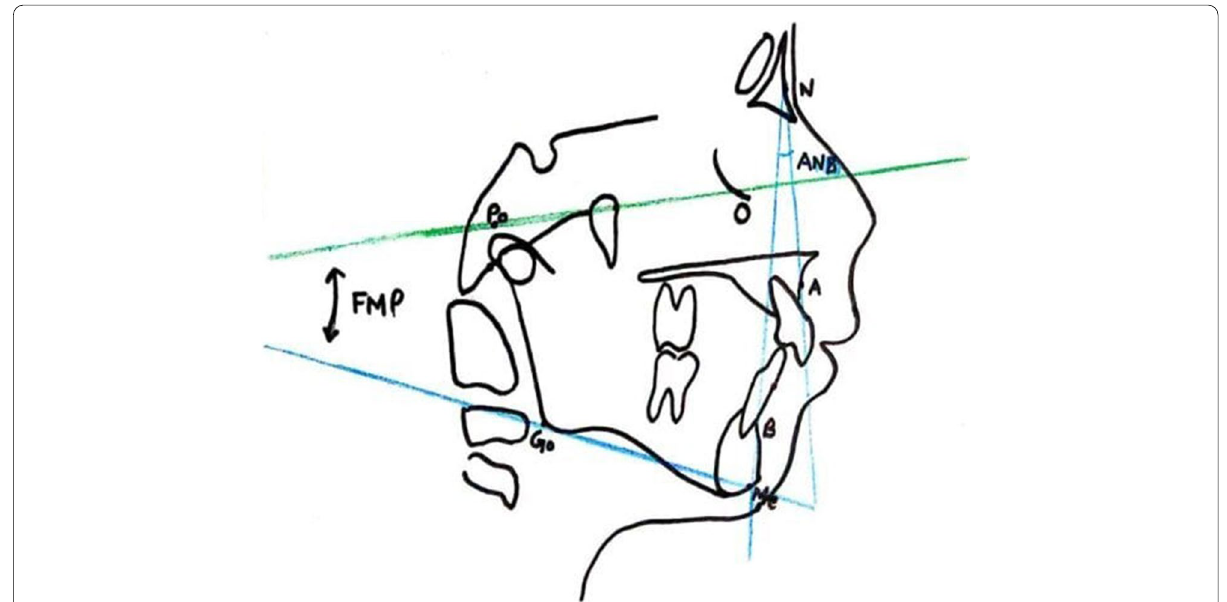
Fig. 2 Lateral cephalometric analysis, specifically ANB angle and FMP (Frankfurt mandibular plane)/MPA (mandibular plane angle)